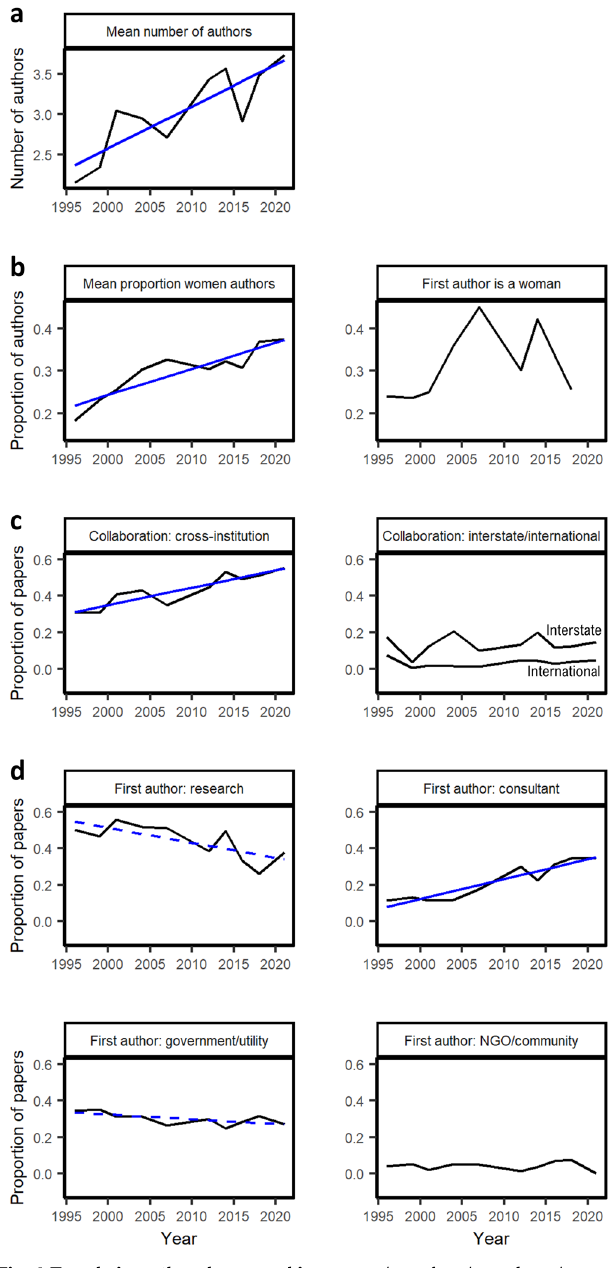
Fig. 1 Trends in author demographics. a number of authors, b author gender (mean proportion of women in authorship teams, proportion of papers with a woman as fi rst author); c collaboration (proportion of papers which are cross-institution, interstate, and international collaborations); and research institutes. Government/utility af fi liations included all levels of government including catchment management agencies and water utilities. Black lines show data, solid blue lines indicate trends with p < 0.01 (considered here to be signi fi cant trends), dashed blue lines indicate trends with 0.01 < p < 0.05 (considered here to be trends supported by weak